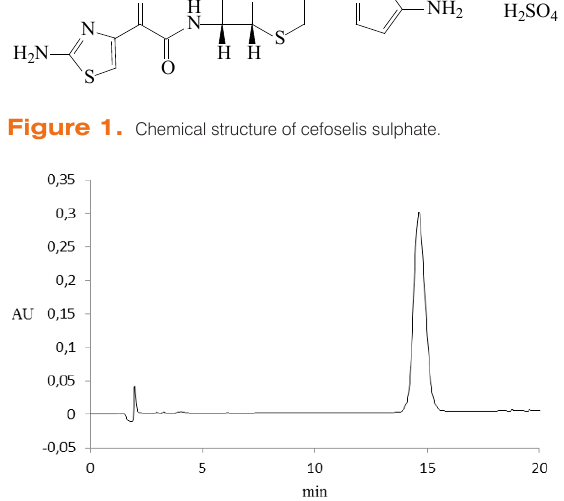
Figure 2. The HPLC chromatogram of blank sample of cefoselis sulphate (retention time 14.58 min).